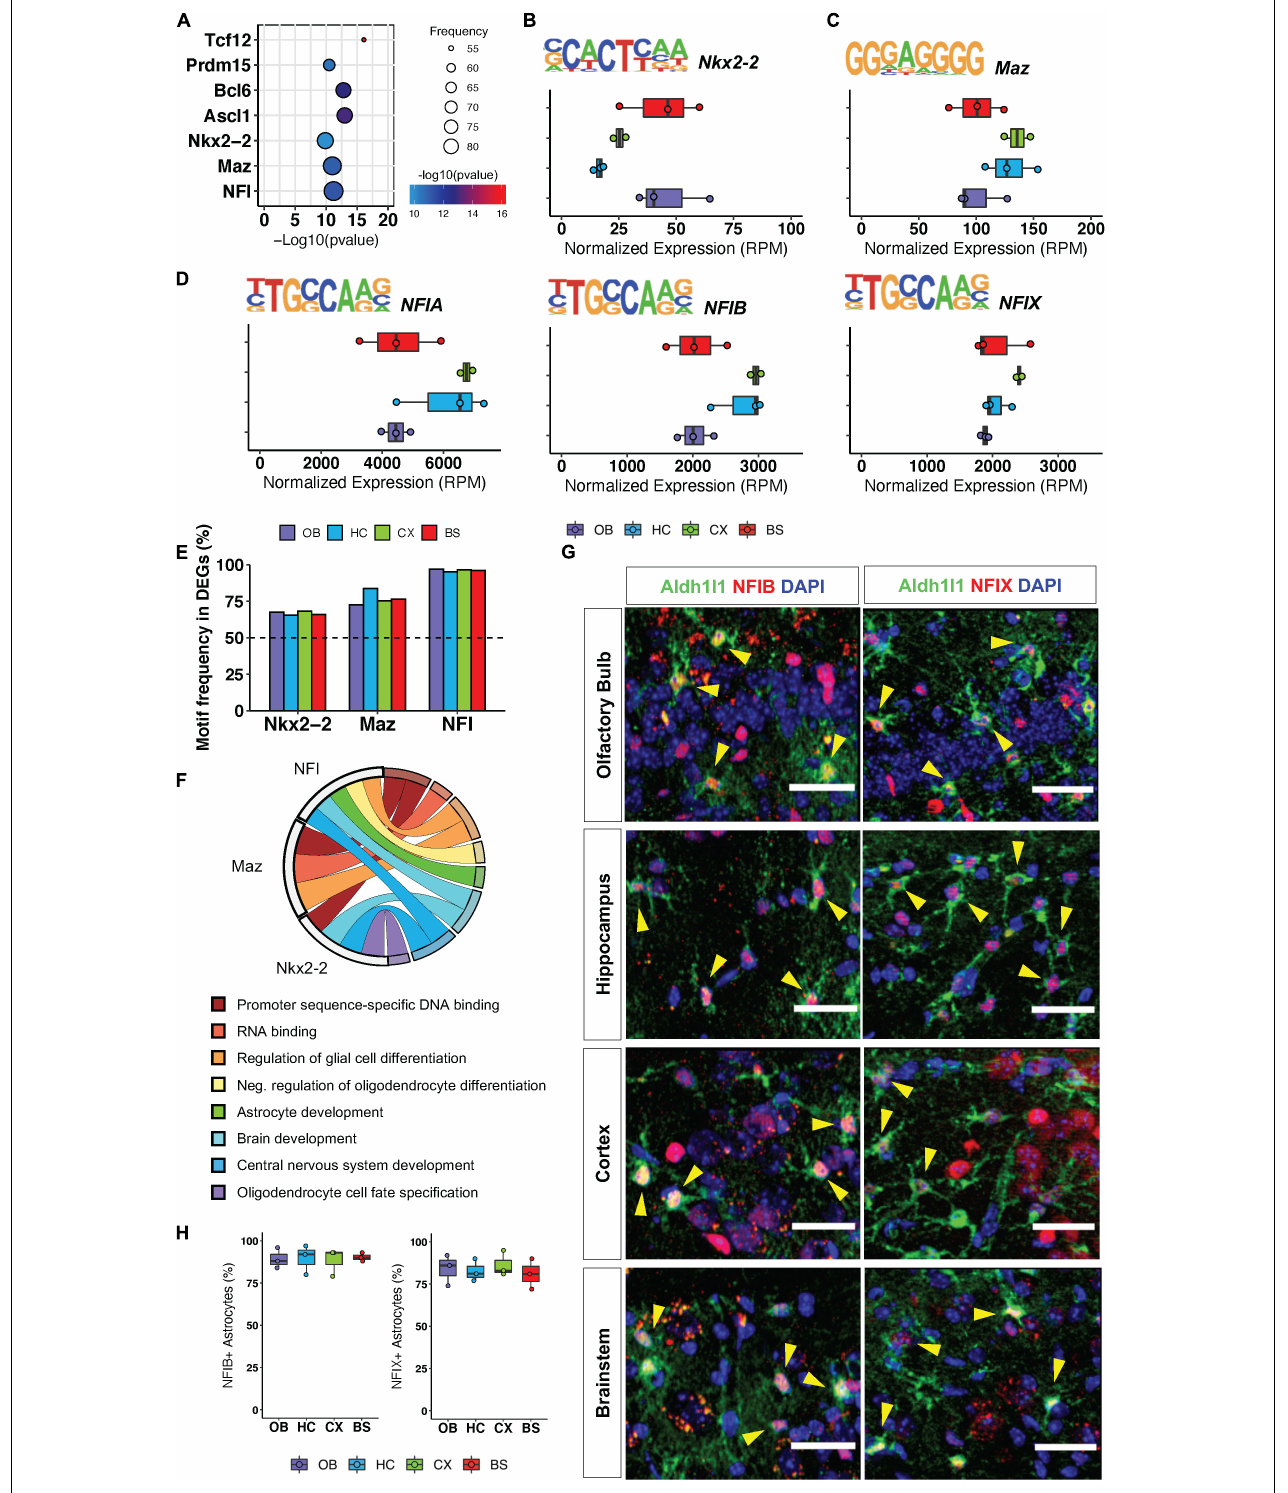
FIGURE 3 | Regional gene signatures exhibit universally conserved transcription factor motif enrichment. (A) Significant transcription factor motifs enriched in all regional DEGs. (B–D) Motif sequence and normalized expression of top 3 most significantly enriched motifs across surveyed brain regions (B) Nkx2-2, (C) Maz, (D) NFIA/NFIB/NFIX. (E) Frequency of motif occurrence in each region DEGs (F) Statistically significant Gene Ontologies associated with each transcription factor. p -value < 0.05. (G) Representative images of immunofluorescence staining of Aldh1l1-eGFP (green) and NFIB or NFIX (red). Yellow arrows indicate double positive cells. (H) Quantification of immunofluorescence staining. n = 3 scale bar = 50 µ m.